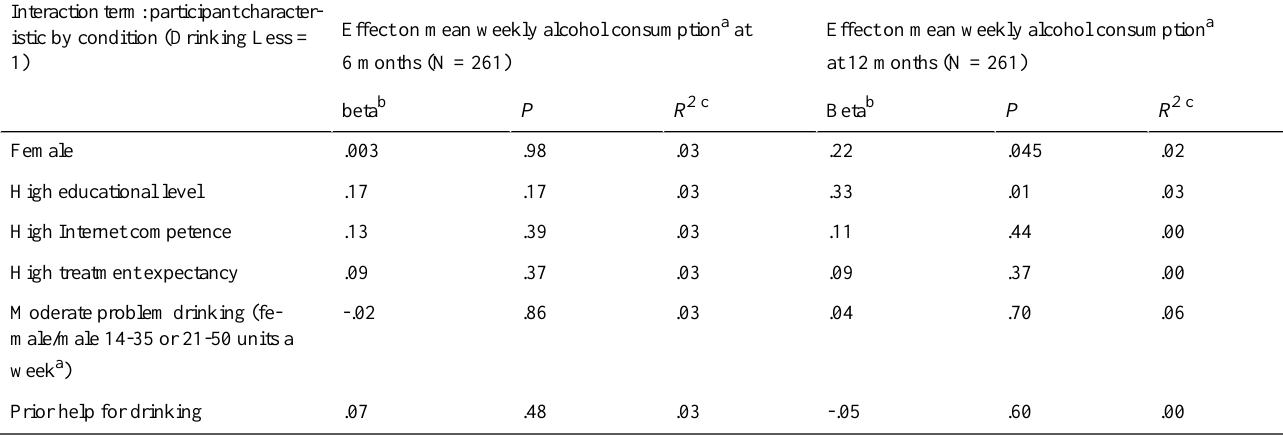
Effect on mean weekly alcohol consumption a at 12 months (N =